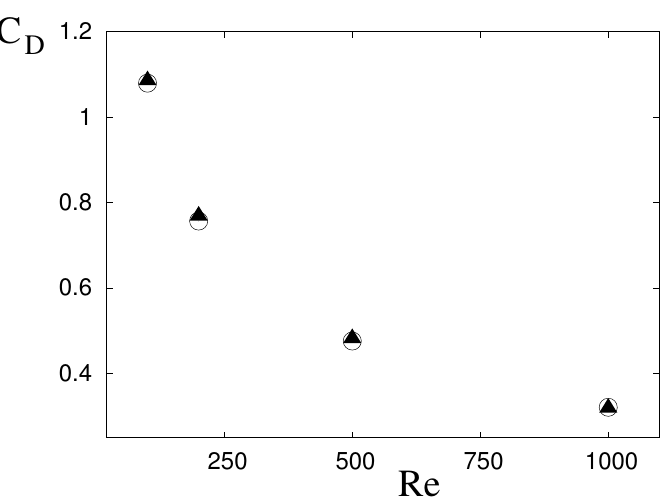
Figure 3. Drag coefficient as function of the Reynolds number for the flow around a sphere ( Γ → ∞ ): ◦ present results, filled (cid:52) data from